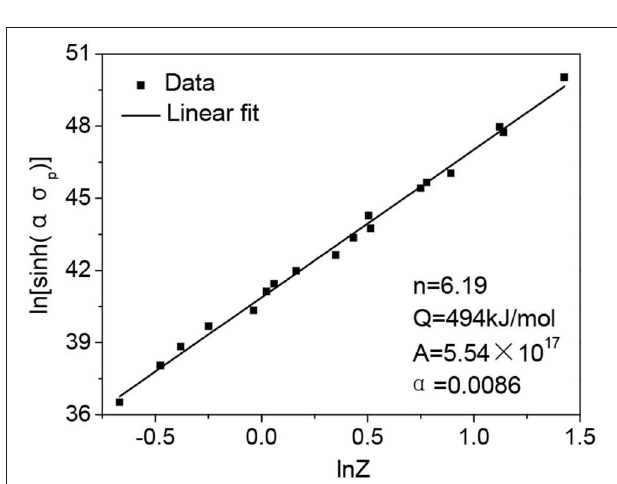
FIGURE 2 | Stress-strain curves 316LN steel in several deformation conditions.